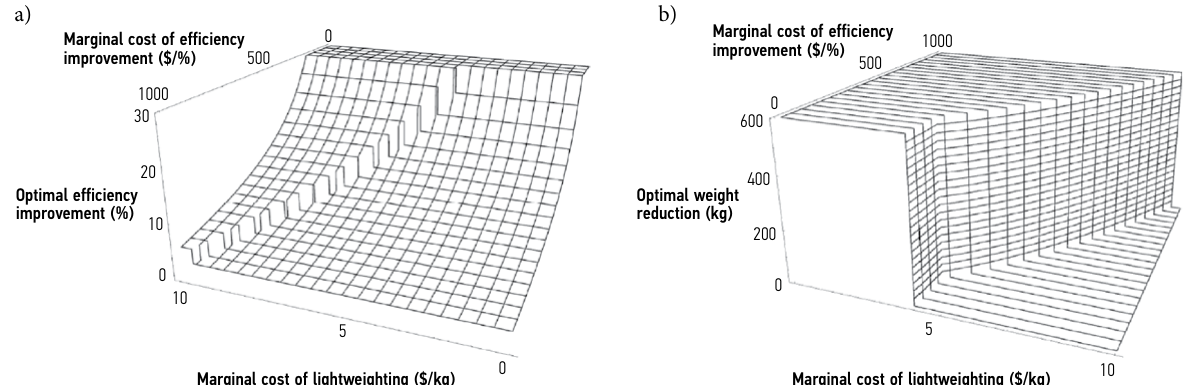
Fig. 4. Optimal levels of efficiency improvement above baseline (a) and weight reduction (b) for various fixed (i.e. constant) lightweighting and efficiency marginal technology